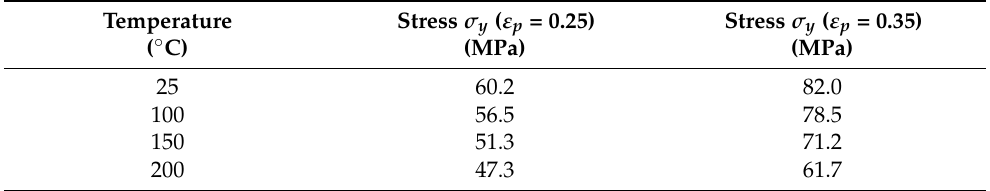
Table 9. Stresses corresponding to different plastic strains under different temperatures. (4500 s − 1 ).